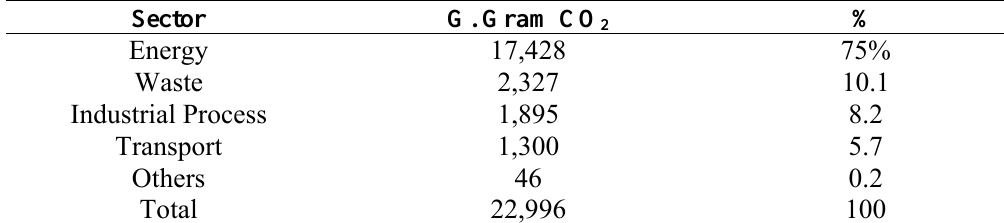
Table 3. Major sector GHG emission in the state of